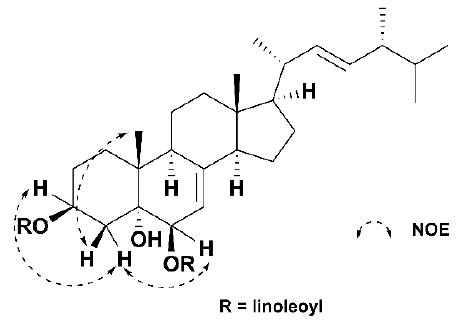
Figure 3. NOESY correlations of 1 .